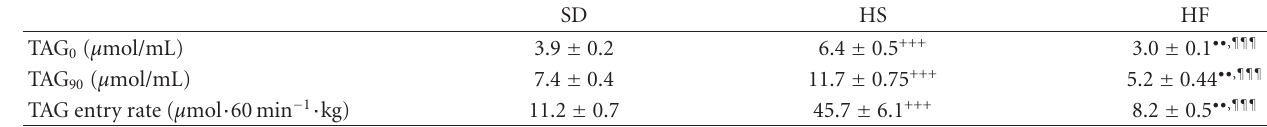
Table 5: E ff ect of HS and HF diet on TAG entry